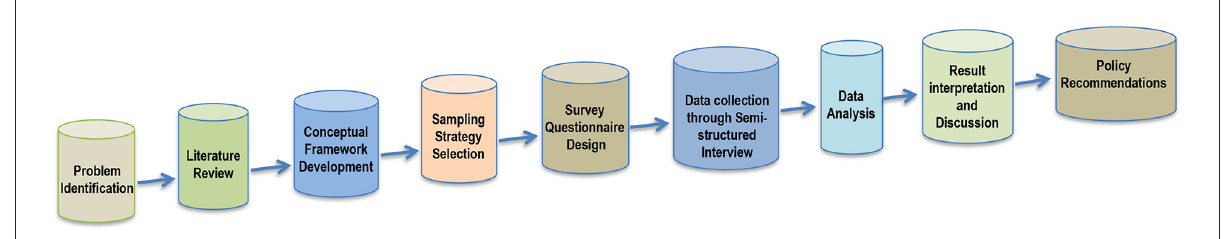
FIGURE1 Methodological steps followed for this